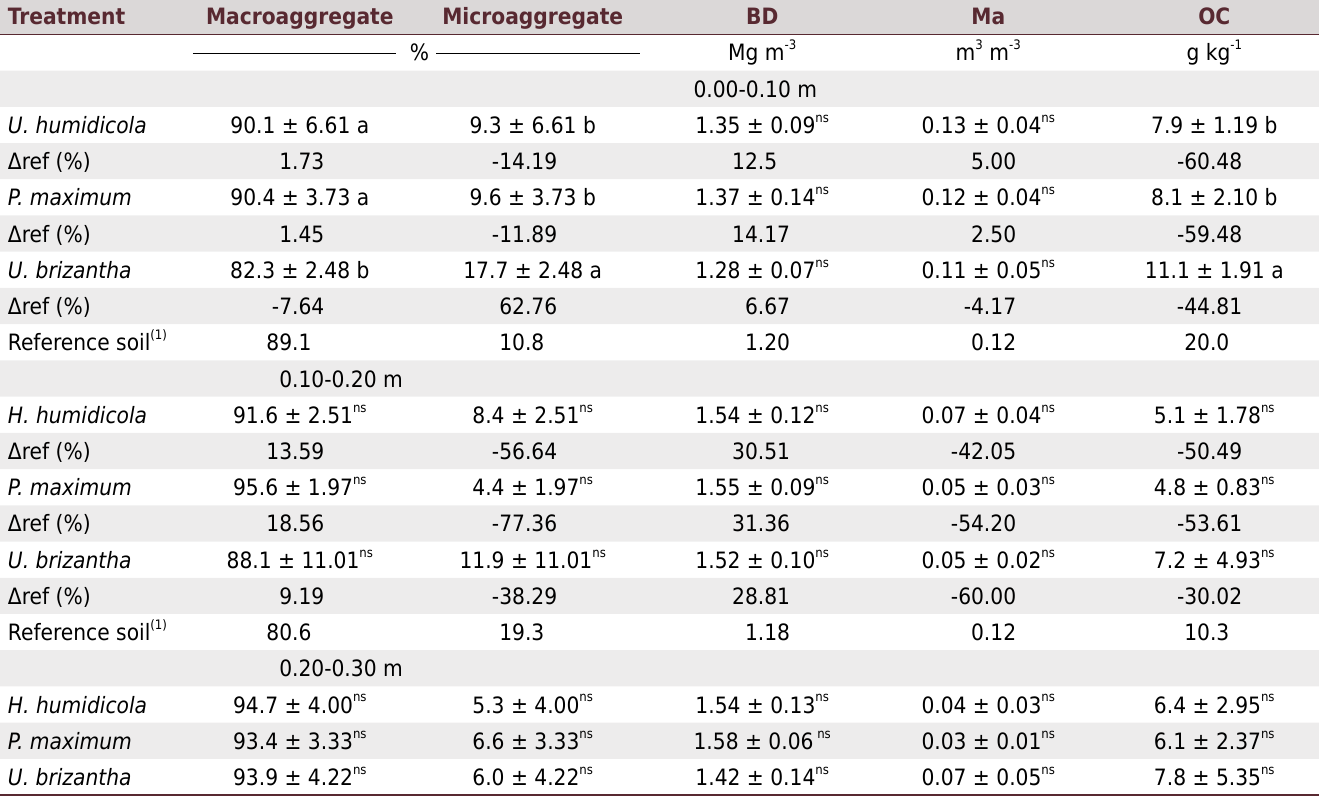
Table 5. Macro- and microaggregates, soil bulk density (BD), macroporosity (Ma), and organic carbon (OC) in the 0.00-0.10, 0.10-0.20, and 0.20-0.30 m layers of the constructed minesoil 58 months after revegetation, and their differences in comparison to the reference soil (natural soil under native vegetation) Treatment